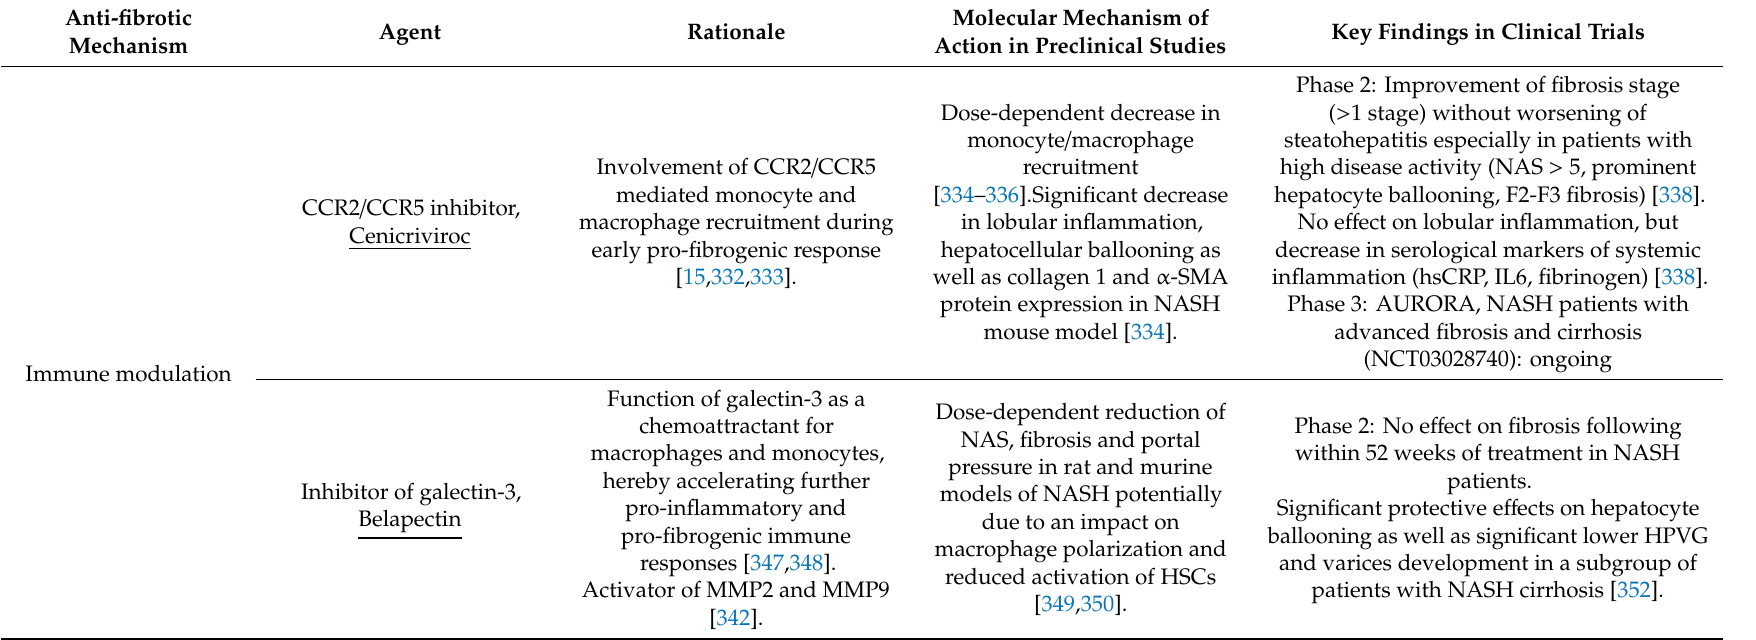
Table 3. Examples for compounds in clinical development aiming to reduce fibrosis by immune